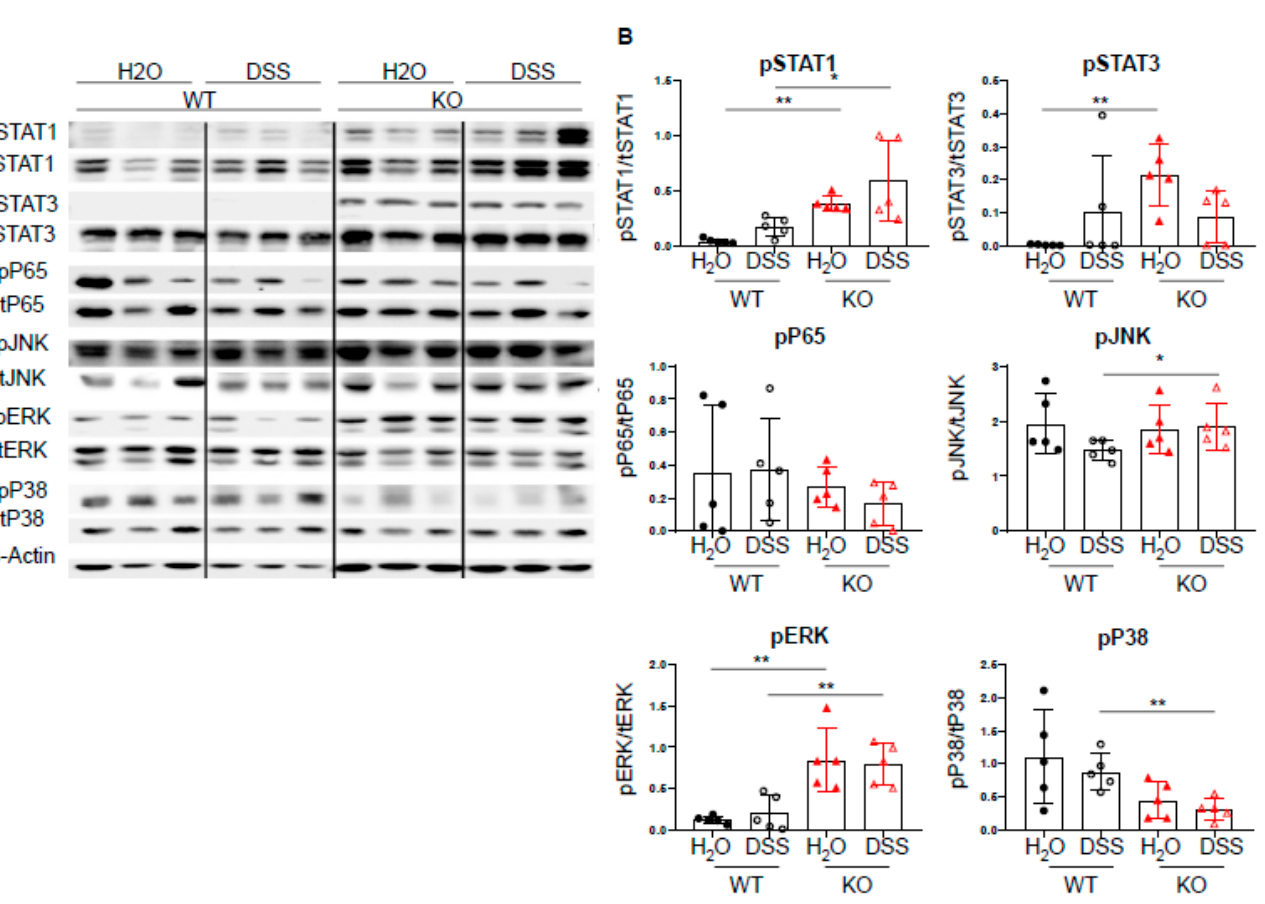
Figure 4. DC-specific PTPN2 regulates phosphorylation of STAT1 in acute DSS colitis. Protein lysates from whole colon pieces of PTPN2 fl/fl (WT) and PTPN2 fl/fl xCD11c Cre (KO) mice were analyzed by Western blot for the indicated proteins: ( A ) pictures show representative blots from 3 mice per group; ( B ) densitometric analysis, phosphorylated proteins are normalized to their respective total forms. * p < 0.05, ** p < 0.01; unpaired Mann–Whitney test. Data are representative for one out of two independent experiments with 4–5 mice per experimental group.